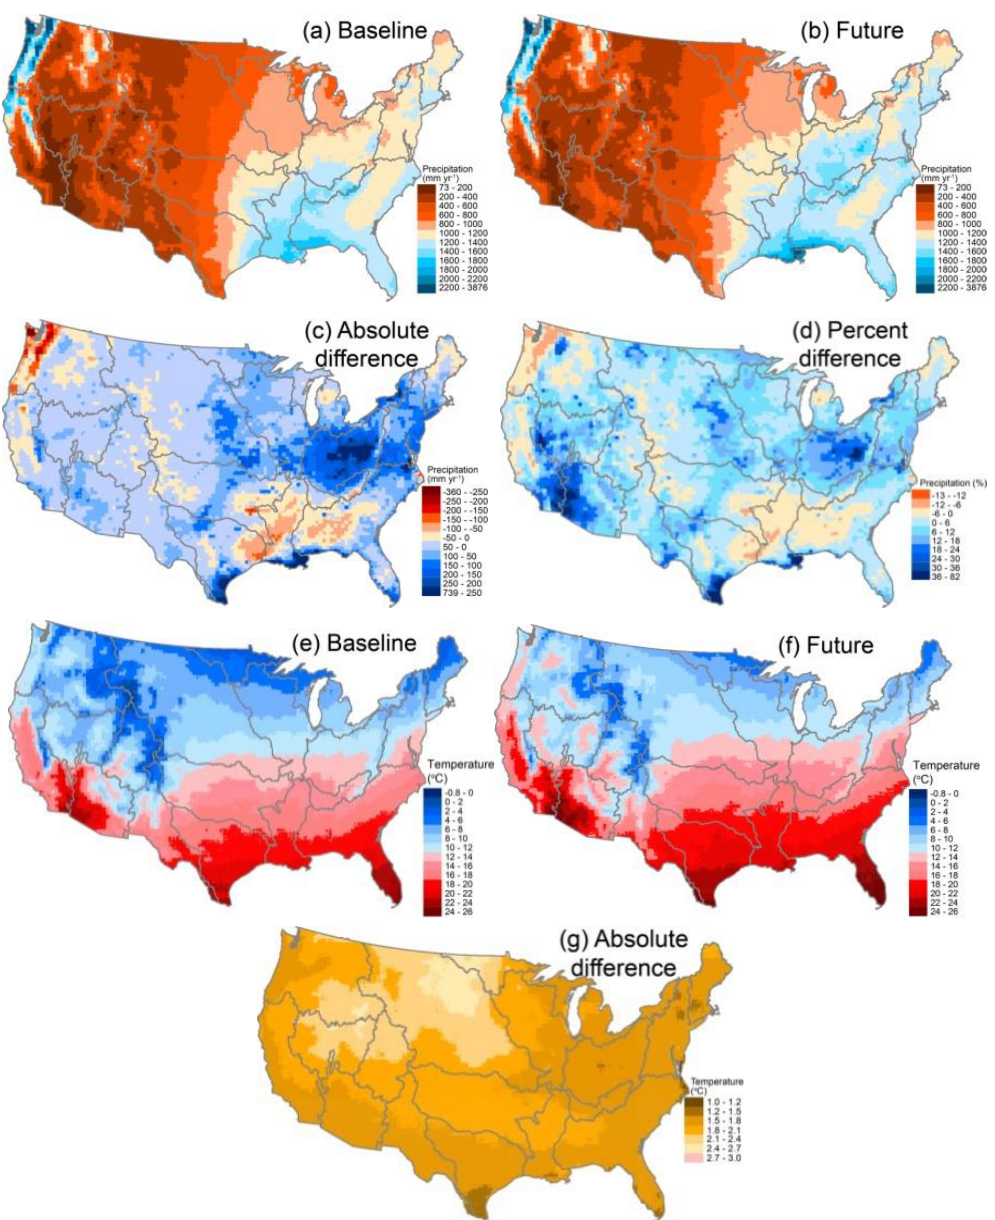
Figure 2. Characteristics of precipitation and temperature during the baseline (1979–2007) and the future periods, and the future changes (future –